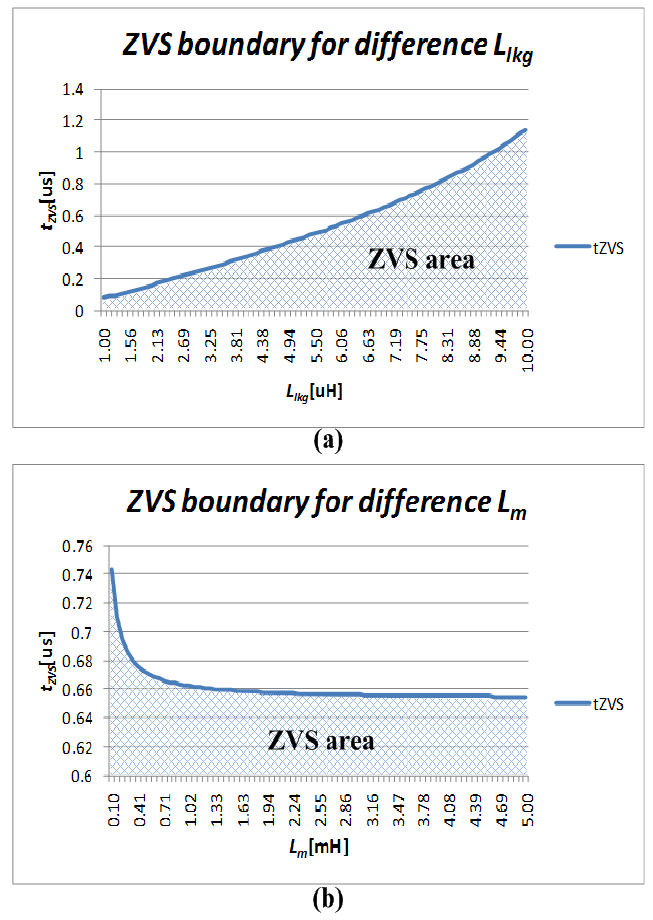
Figure 9. ZVS area of the primary side switching device according to ( a ) leakage inductance and ( b ) magnetizing inductance.